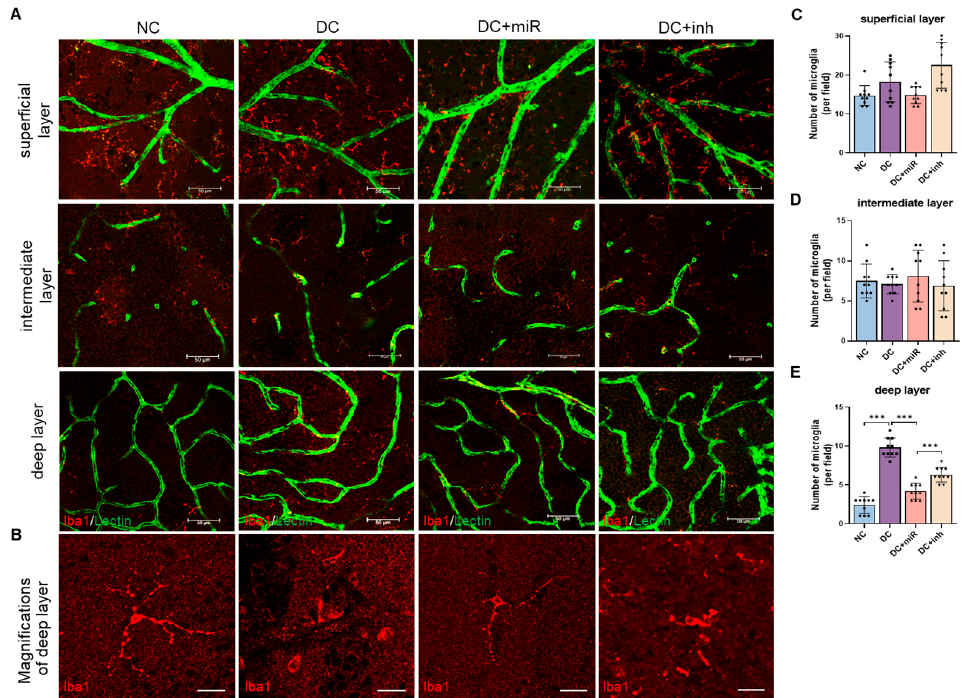
Figure 3. miR-124 normalized deep layer microglial activation in diabetic retinae. ( A ) Representative images of co-immunofluorescent staining of Iba1 (red) and Lectin (green) in the whole mount retinae from non-diabetic control (NC) rats, diabetic rats (DC), DC treated with miR-124 (DC+miR), or DC treated with miR-124 inhibitor (DC+inh) in superficial, intermediate, and deep vascular layer. The images were taken with the Leica confocal microscope SP8, scale bar = 50 µ m. ( B ) The representative images of magnifications of Iba1 staining in the deep layer. Scale bar = 20 µ m. ( C – E ) Quantification of microglia in the superficial layers ( C ), intermediate layers ( D ), and deep layers ( E ) of rat retinae. The quantification of microglial numbers was exhibited as mean ± SD, n = 10, *** p < 0.001 (one-way ANOVA with Tukey’s multiple comparisons